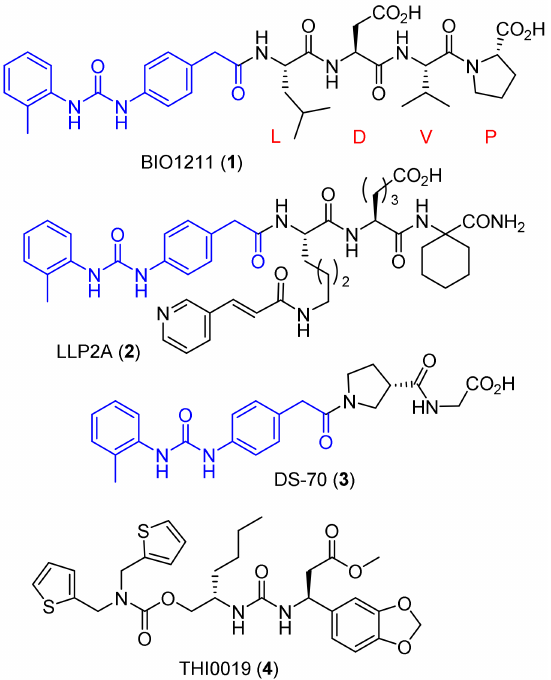
Figure 1. Examples of linear peptidomimetics targeting the α 4 β 1 integrin receptor, some of which have been advanced in preclinical studies [13,18,22,24]. The MPUPA moiety is depicted in